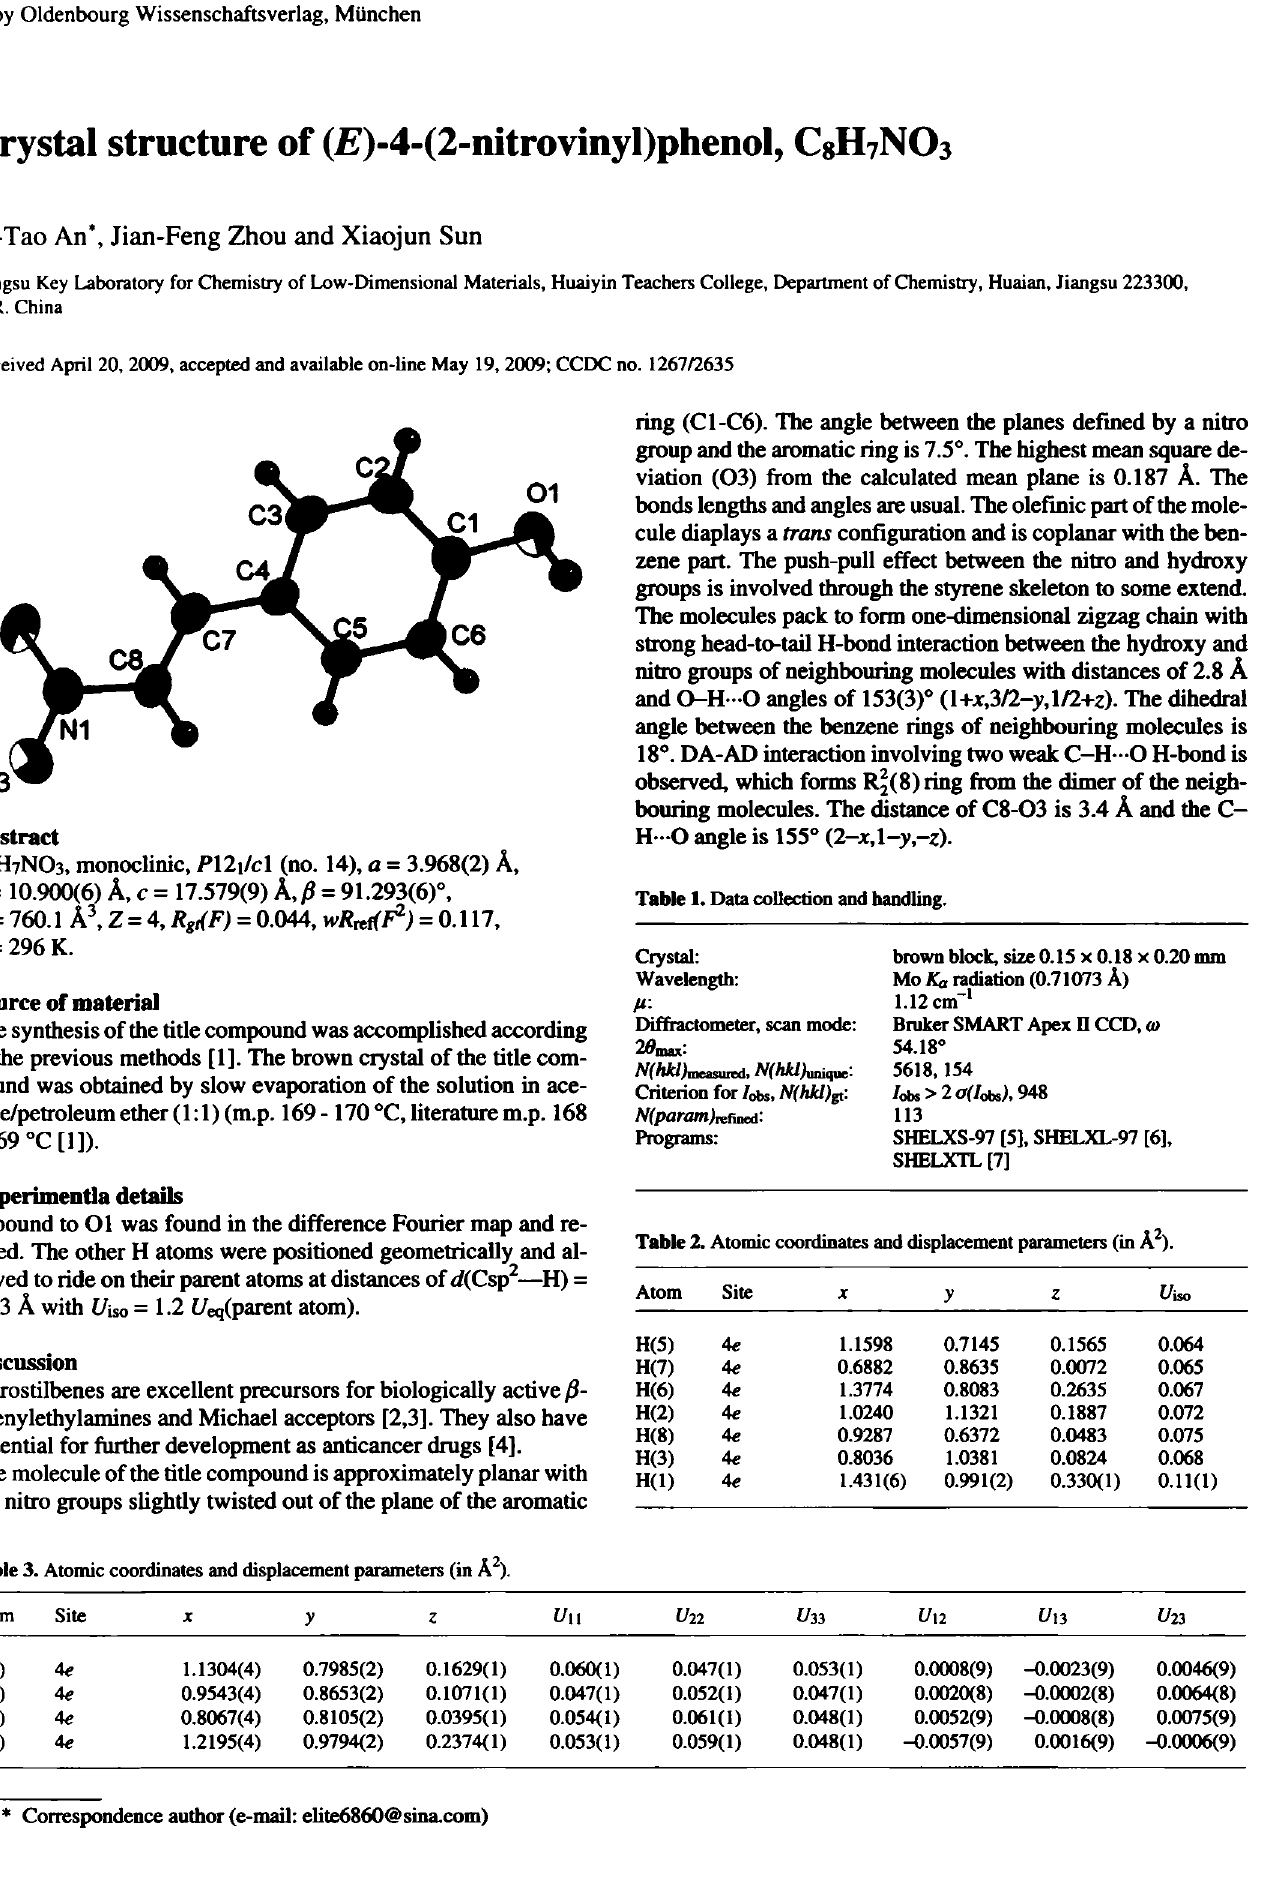
Table 3. Atomic coordinates and displacement parameters (in Â 2